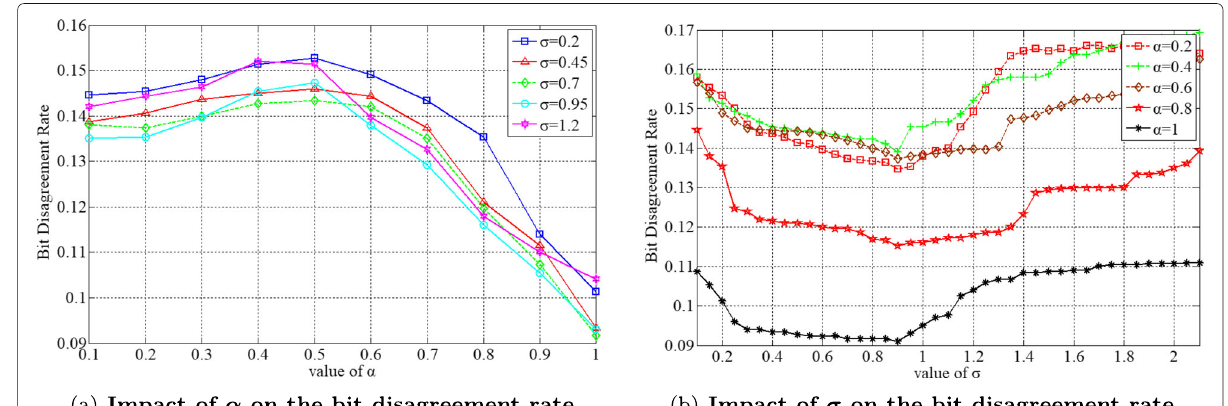
Fig. 16 Impact of α and σ on the bit disagreement rate